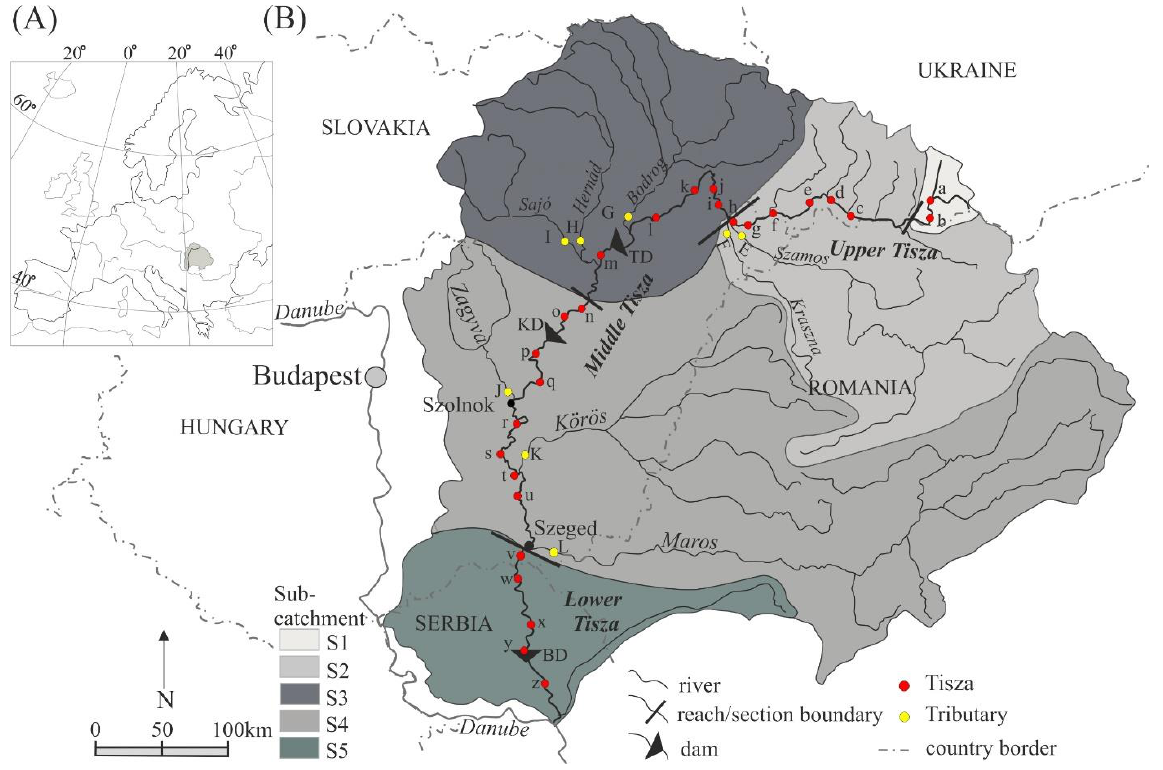
Figure 1. ( A ) The study area is located in Central Europe. ( B ) The research was performed along the Tisza River (Sites a – z) and its tributaries (Sites E – L). The flow of the Tisza is controlled by three dams at Tiszalök (TD), Kisköre (KD) and Novi Becej (ND). The grey colors indicate the sub-catchments of the sections (S1 – S5).